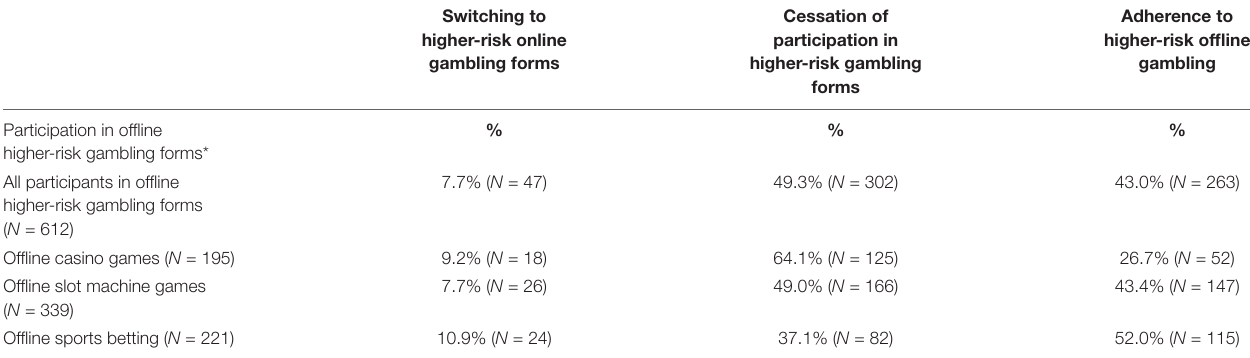
TABLE 2 | Development of gambling behavior between the periods before and after the first